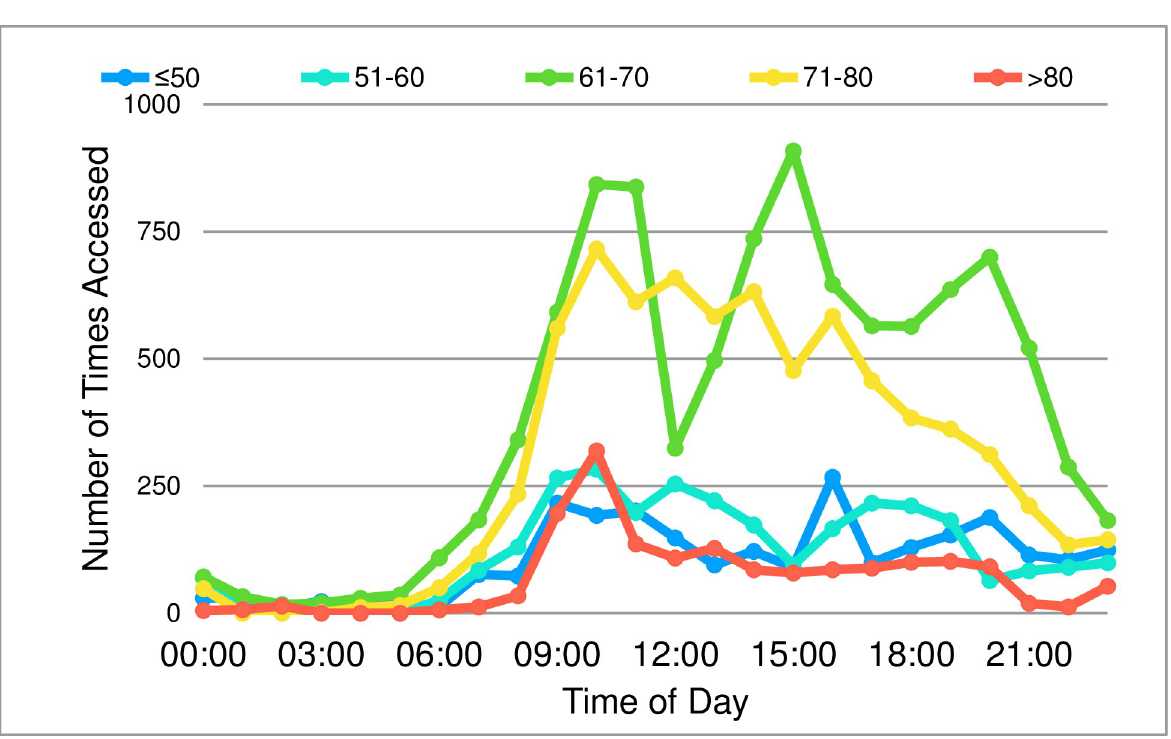
Fig 4. Number of accesses to the ODP across the day dependent upon age